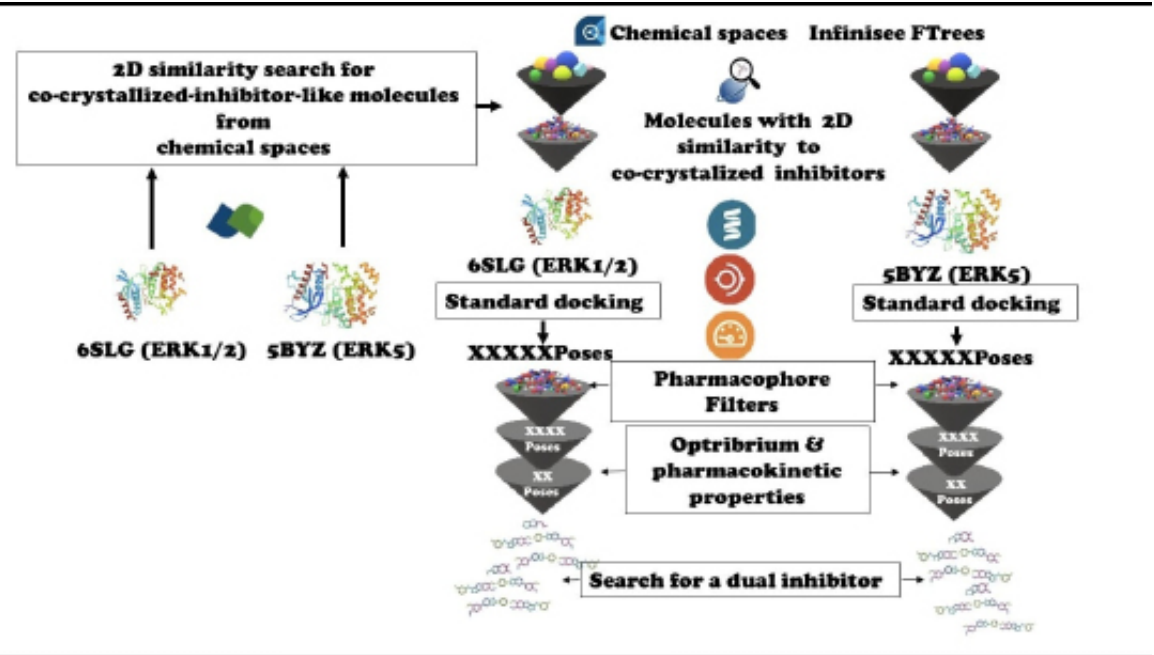
Figure-I: Graphical